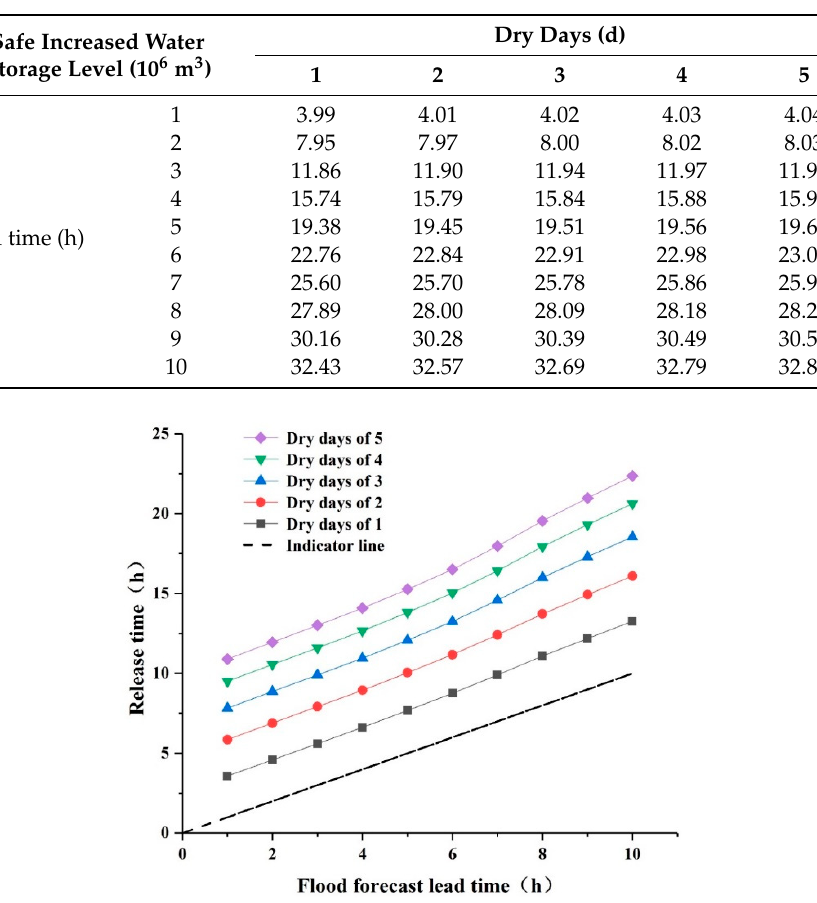
Table 6. Safe level of increased water storage in di ff erent scenarios.